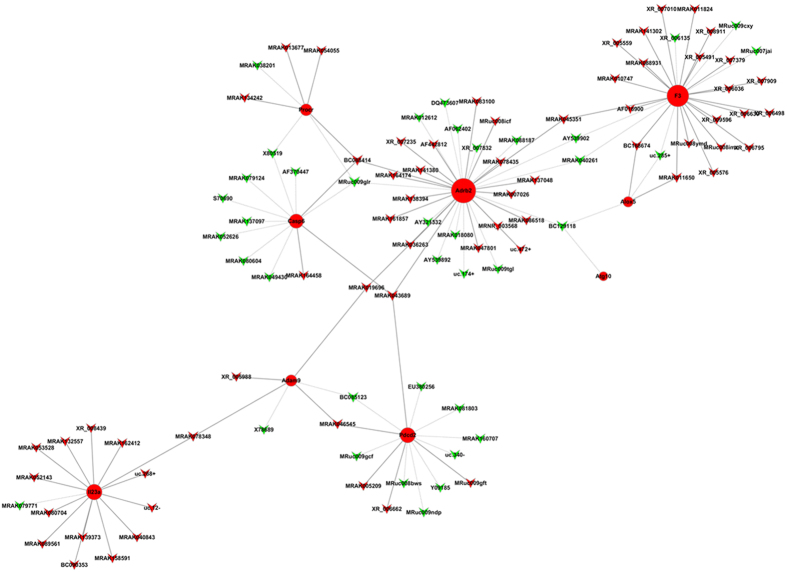
Coding non-coding gene co-expression networks of the nine differentially expressed mRNAs.The network represents co-expression correlations between the nine mRNAs and significantly differentially expressed lncRNAs. Nodes represent coding genes, and circles represent lncRNAs. Red indicates upregulated genes and green indicates downregulated gens. Solid lines indicate positive correlations, and dashed lines indicate negative correlations.